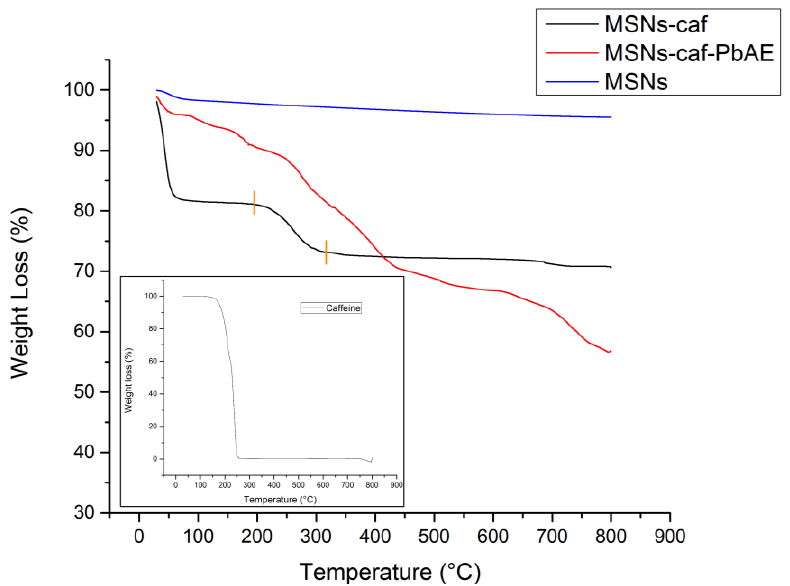
Figure 4. Thermogram curves of the caffeine sample (inset), MSNs, MSNs-Caf, and MSNs-Caf- PbAE.